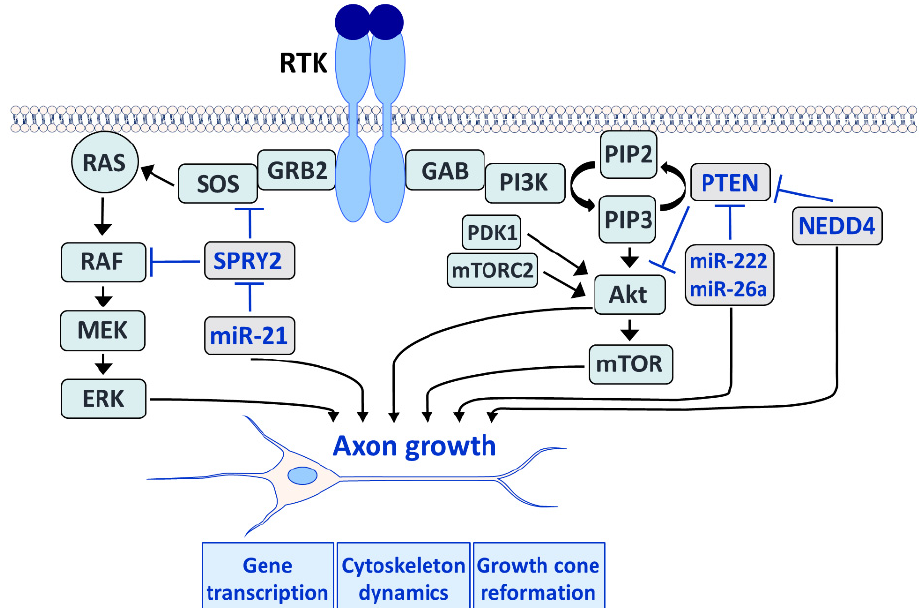
Figure 3. The RAS/ERK (left) and the PI3K/Akt (right) pathways play an important role in axon growth during development and regeneration in the adult. Both pathways induce gene expression in the neuronal cell body and control cytoskeleton dynamics in the axon. Furthermore, both pathways influence the growth cone reformation after lesion. The RAS/ERK pathway (left) is induced after RTK activation by the GRB2 adaptor molecule that recruits SOS, which in turn activates RAS. RAS recruits rapidly accelerated fibrosarcoma (RAF) to the plasma membrane where it is activated and induces mitogen-activated and extracellular signal-regulated kinase (MEK) that phosphorylates ERK. SPRY2 interacts with the ERK pathway by interfering with GRB2 and RAF. Activation of ERK is increased by SPRY2 deletion and enhances axon regeneration. MicroRNA-21 (miR-21) downregulates SPRY2 and is induced after nerve injury to promote axon regeneration. The PI3K/Akt pathway (right) is induced by the adaptor protein GRB2-associated binder (GAB) which activates PI3K. Activated PI3K phosphorylates PIP2 to generate phosphatidylinositol 3,4,5-trisphosphate (PIP3). The accumulation of PIP3 recruits Akt to the plasma membrane, and Akt is phosphorylated by phosphoinositide-dependent kinase 1 (PDK1) and mammalian target of rapamycin (mTOR) complex 2 (mTORC2). Akt then activates mTOR, and both Akt and mTOR promote axon regeneration. PTEN converts PIP3 to PIP2 by dephosphorylation, thereby reversing the reaction catalyzed by PI3K and inhibiting Akt and mTOR activation. MiR-222 and miR-26a downregulate PTEN and are regulated after nerve lesion or during brain development, respectively. Deletion of PTEN enhances axon regeneration via the activation of Akt and mTOR. MiR-222 and miR-26a promote axon growth by the downregulation of PTEN whereas the disruption of the PTEN-regulating ubiquitin ligase neural precursor cell expressed developmentally down-regulated protein 4 (NEDD4) upregulates PTEN and impairs axon growth. Activation of ERK promotes axon elongation by cultured embryonic DRG and SCG neurons [22,23]. However, ERK inhibition has no effect on spontaneous axon outgrowth of adult DRG neurons while axon growth in response to NGF stimulation is impaired by ERK